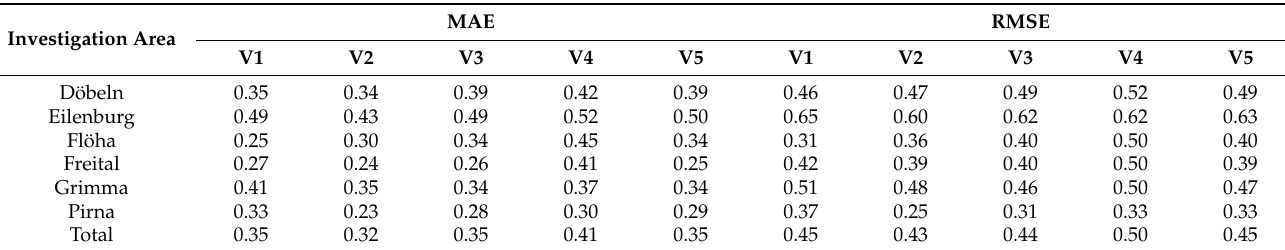
Table 8. Error analysis for Level II (including flow